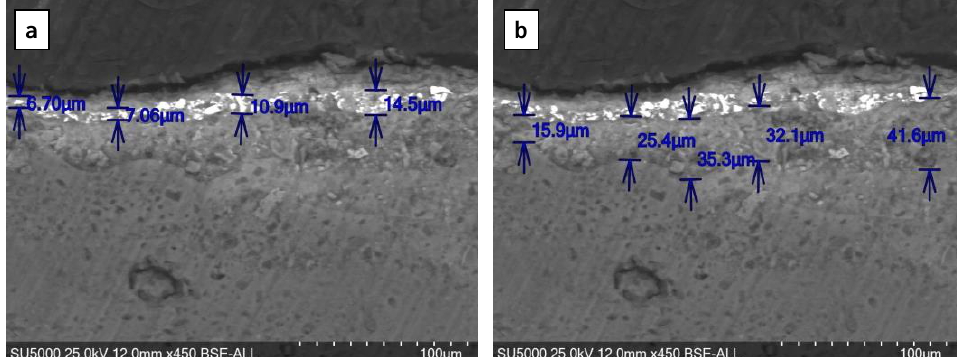
Figure 7. Determination of layer thicknesses from cross-section SEM analysis at ×450 magnification: ( a ) pictorial layer; ( b ) intonaco layer.